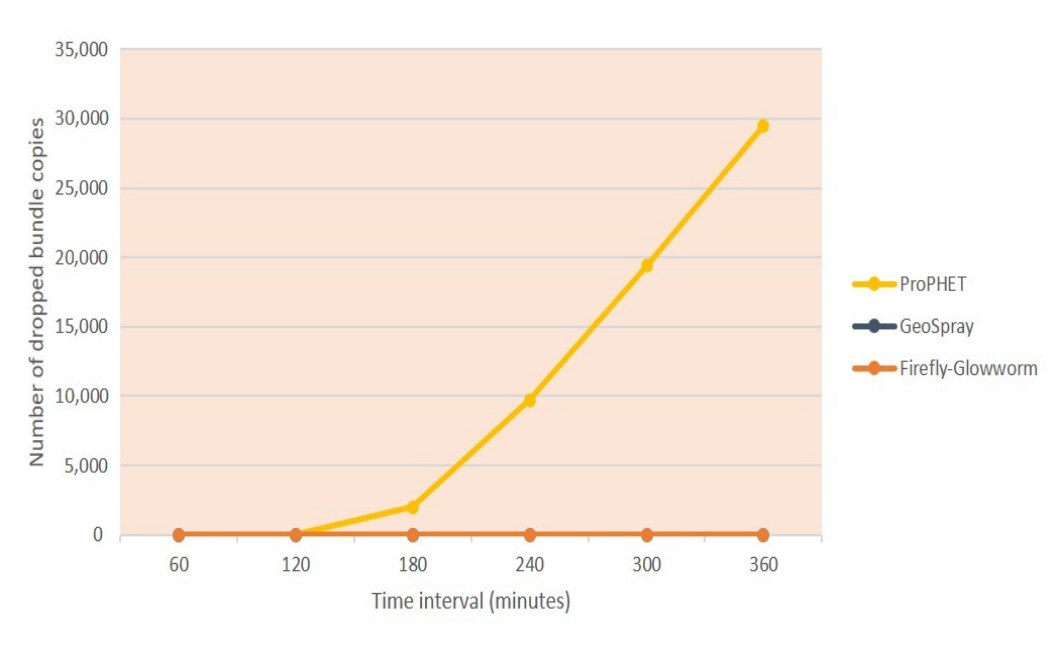
Figure 10. Number of dropped bundle